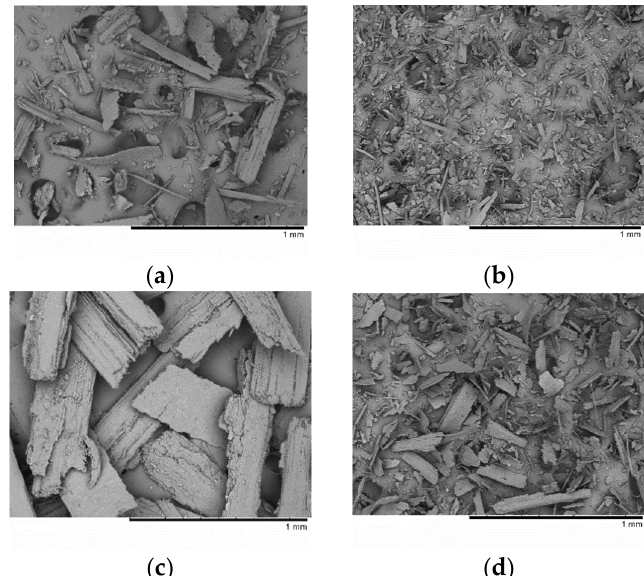
Figure 2. Scanning electron microscopy (SEM) photographs of wheat straw: initial wheat straw ( a ), particles of 32 μ m ( b ), 350 μ m ( c ) and 130 μ m ( d ).